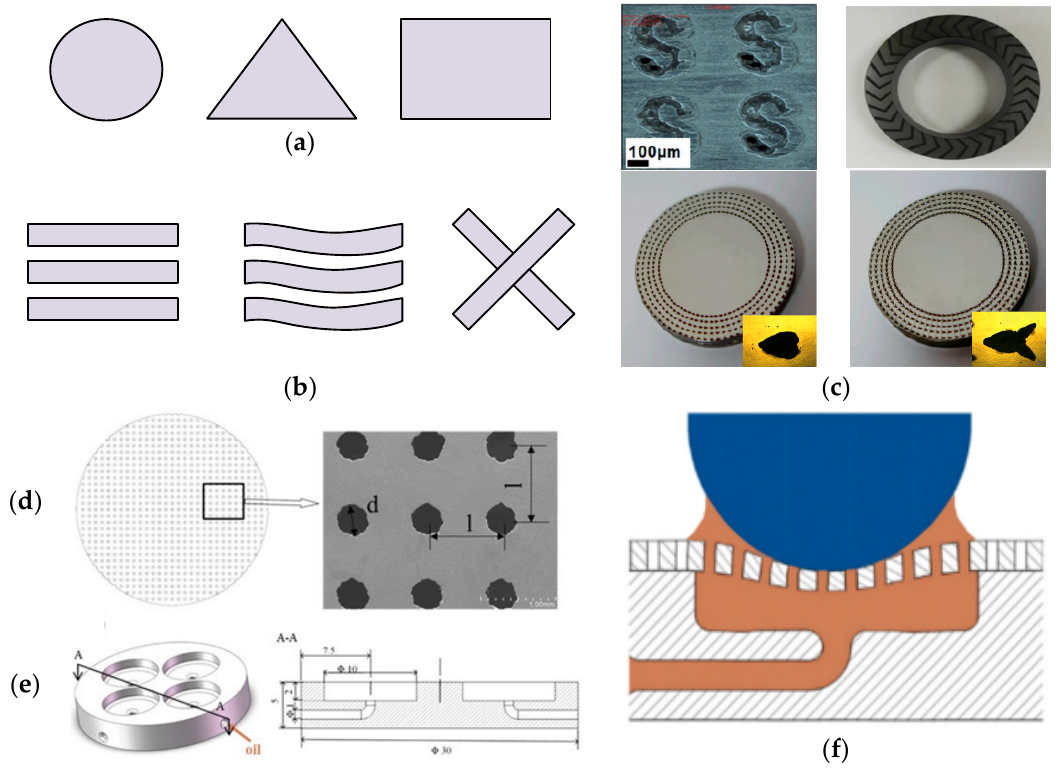
Figure 4. Texture shapes: ( a ) concave textures; ( b ) convex textures; ( c ) optimized texture shapes—‘’S” groove, ’’V’’ shape—reprinted with permission from [67,71], copyright from Elsevier 2021, 2015; bullet and fish shapes—reprinted with permission from [70], copyright from Elsevier 2017 ( d ) textured surface illustration; ( e ) pocket substrate model; ( f ) pocket–-textured surface sample’s effect under applied load, reproduced with permission from [78].